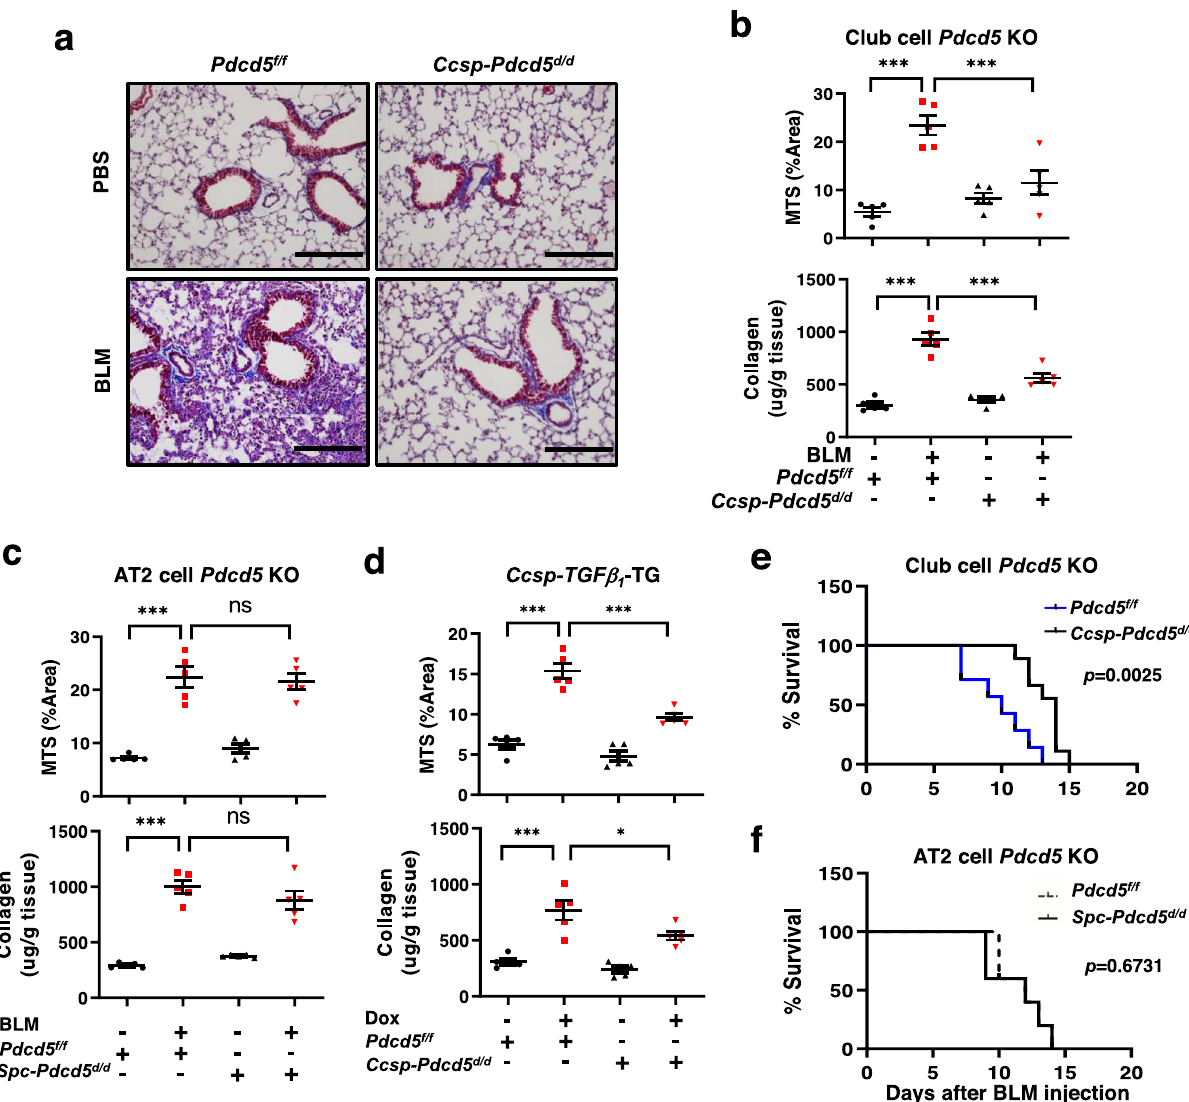
Fig. 2 Club cell-speci fi c deletion of Pdcd5 prevents lung fi brosis. a MTS was carried out on lung tissues from Pdcd5 f/f and Ccsp-Pdcd5 d/d mice with or without BLM treatment (scale bars = 200 μ m). b – d MTS quanti fi cation and soluble collagen assay using lung tissues from Pdcd5 f/f and Ccsp-Pdcd5 d/d